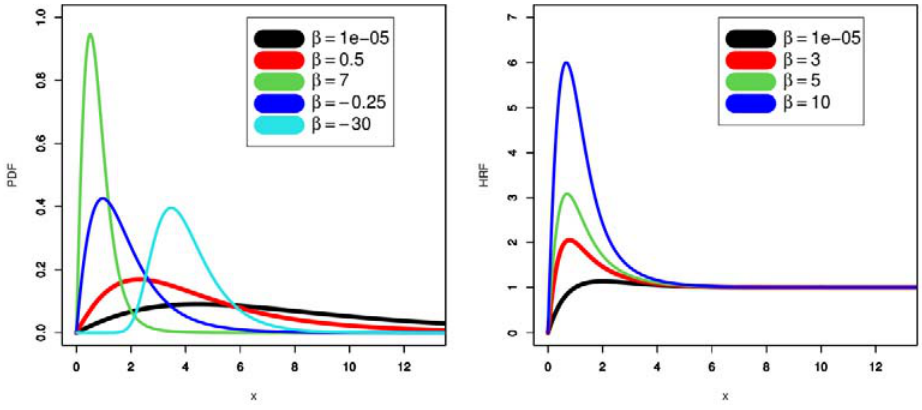
Figure 1. PDF ( the left panel ) and HRF ( the right panel ) for the QPE model.